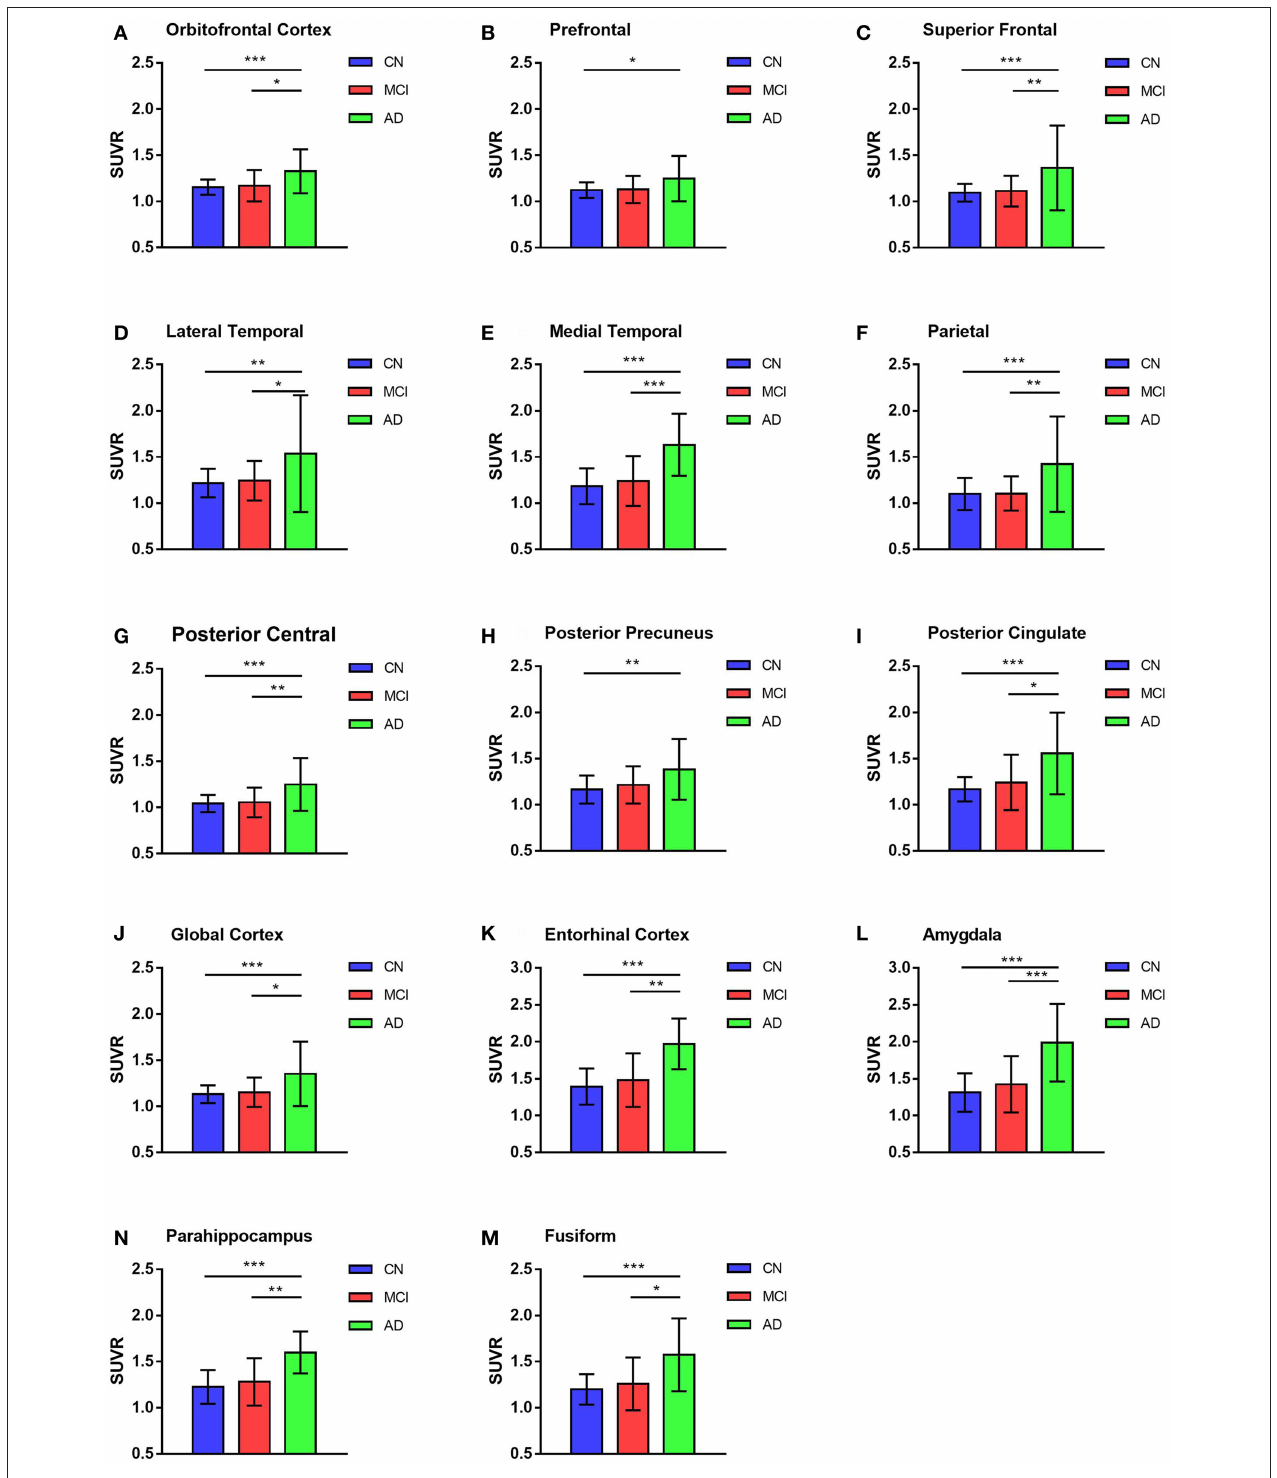
FIGURE 2 | 18 F-AV1451 SUVRs of cortical and subcortical ROIs in AD, MCI, and CN groups. Bar graphs showing ROIs SUVR (mean with error bars depicting SD) comparison among AD, MCI and CN groups in the orbitofrontal cortex (A) , prefrontal cortex (B) , superior frontal cortex (C) , lateral temporal cortex (D) , medial temporal cortex (E) , parietal cortex (F), posterior central cortex (G) , posterior precuneus (H) , posterior cingulate (I) , global cortex (J) , entorhinal cortex (K) , amygdala (L) , parahippocampus (N) and fusiform (M) . P -value was defined using GLM to compare SUVR between CN and MCI, CN and AD, MCI and AD. * p < 0.05, ** p < 0.01, *** p <